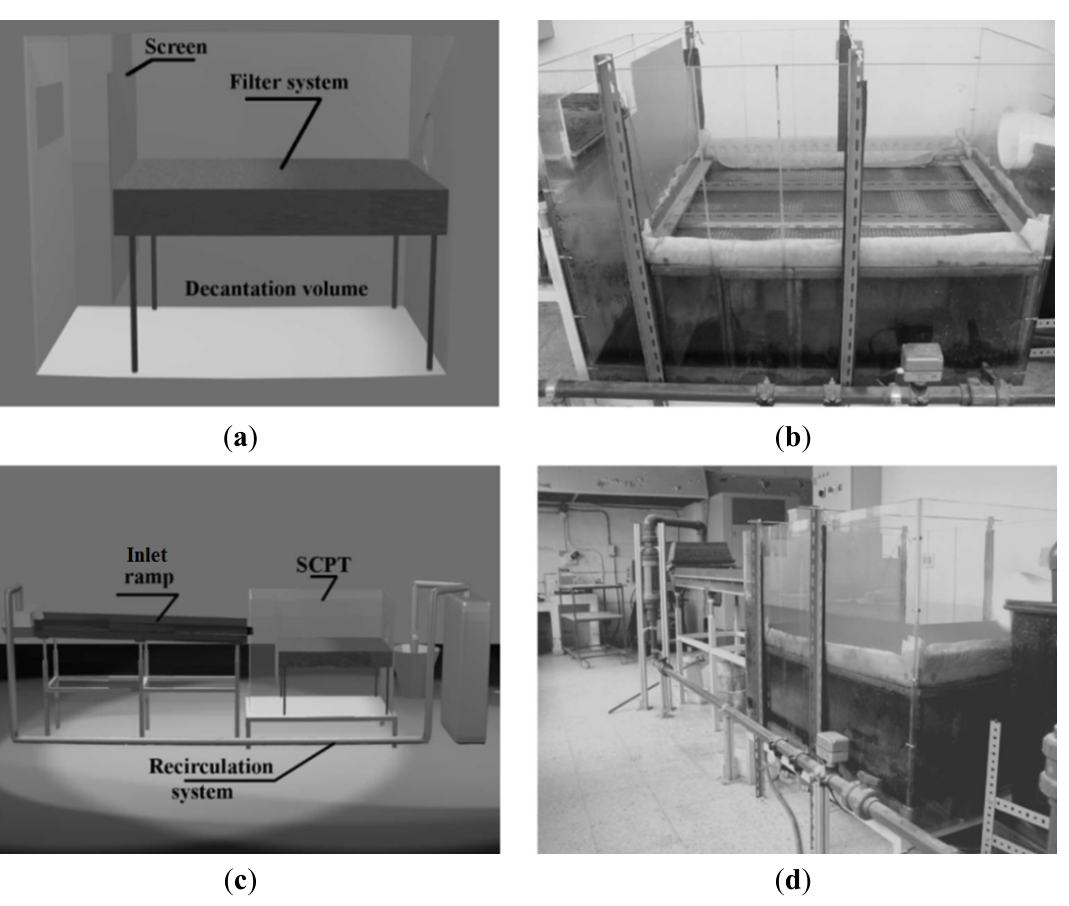
Figure 7. Detail of SCPT [57]: ( a ) Modeled SCPT scheme; ( b ) Constructed SCPT; ( c ) Modeled test system used for SCPT; ( d ) Constructed system for SCPT